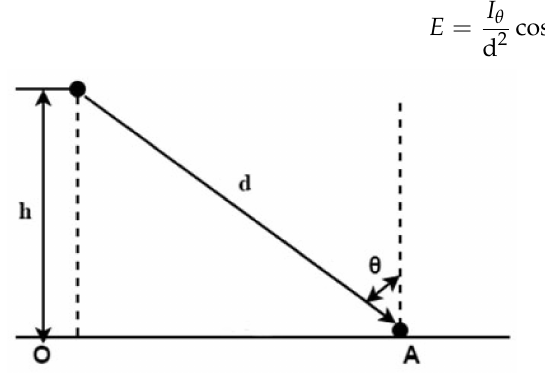
Figure 11. The inverse square law of